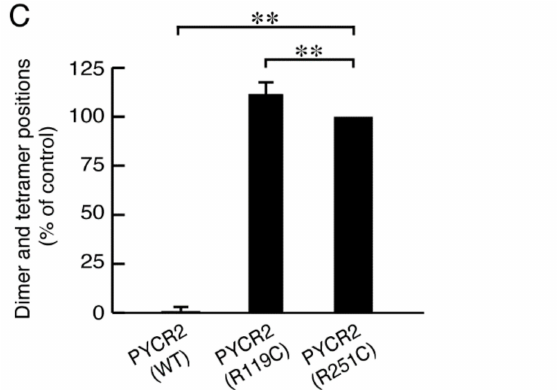
Figure 6. The R119C or R251C proteins, but not the wild type proteins, exhibit dimeric or tetrameric structures in a polyacrylamide gel with a full-size gel image. ( A ) As the control experiments, the lysates of COS-7 cells transfected with mock, an empty vector expressing GFP, or with a plasmid encoding the wild type (WT) were applied to polyacrylamide gel electrophoresis and detected using immunoblotting with an anti-GFP antibody. ( B ) The lysates of COS-7 cells transfected with an empty vector or with a plasmid encoding the wild type (WT) or the respective mutated constructs were applied to polyacrylamide gel electrophoresis and detected using immunoblotting with an anti-GFP antibody. The positions corresponding to monomeric or polymeric structures are